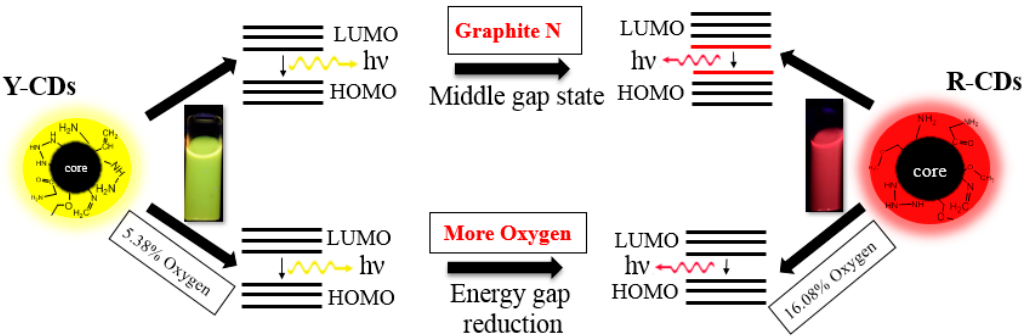
Figure 7. A possible luminescence mechanism for CDs.